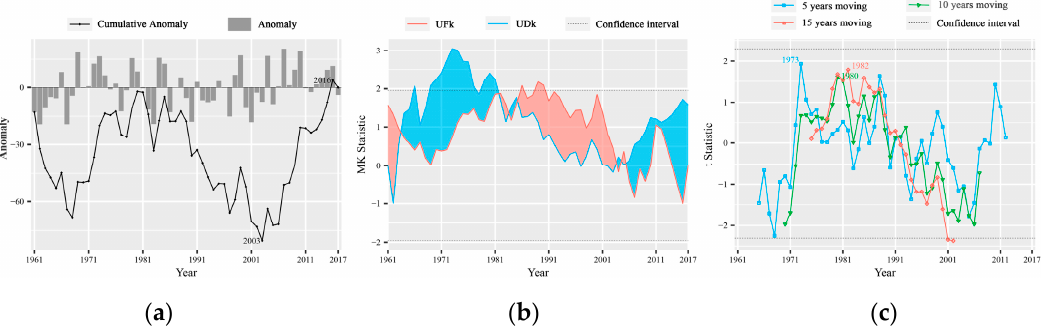
Figure 3. The abrupt change point identification diagram of spring ET 0 sequence, where the picture Figure 3 category of the ( a – c ) is same to Figure 2.